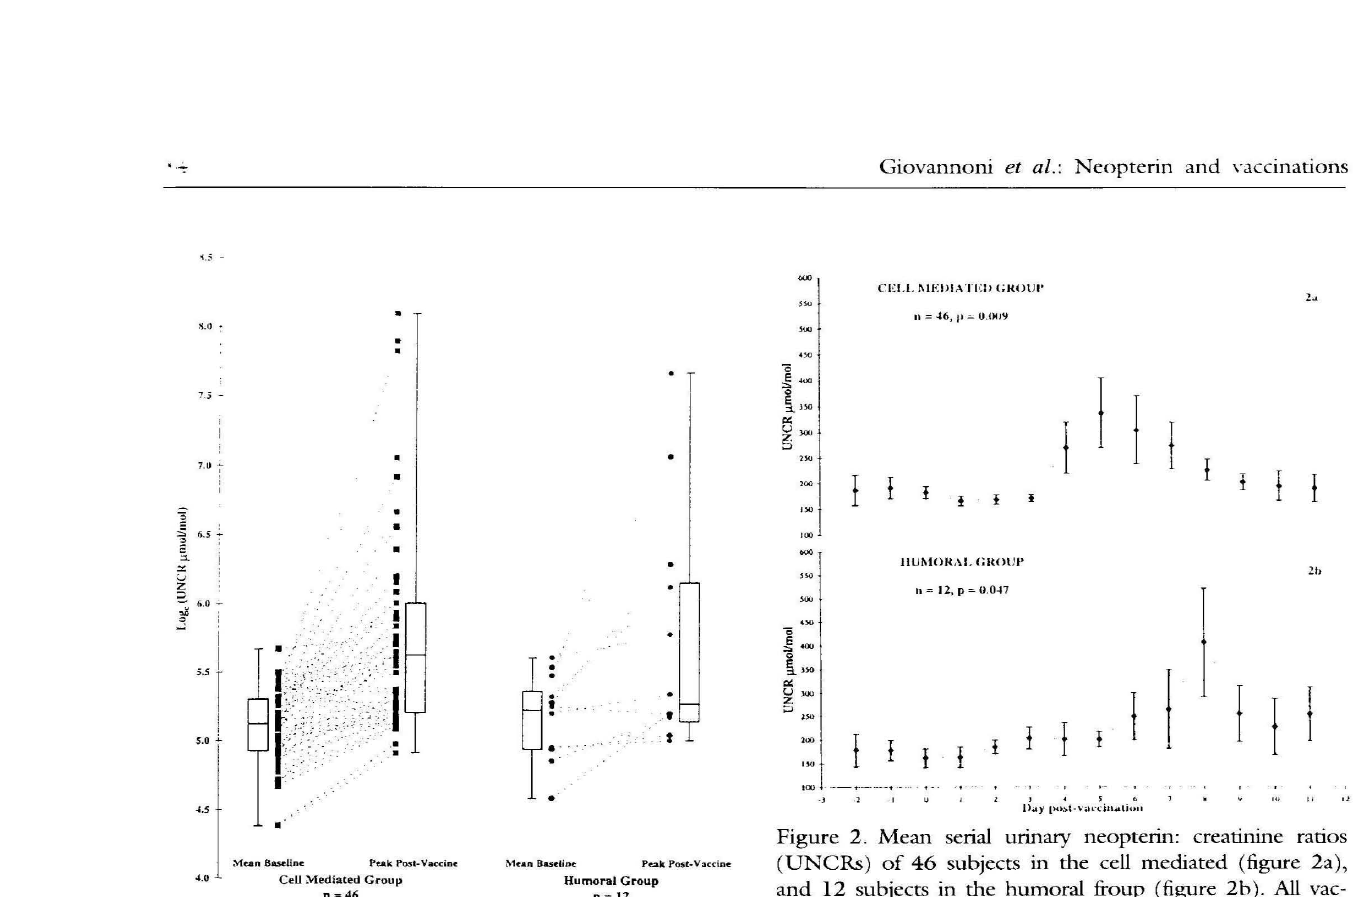
Figure 1. Scatter and box and whisker plot of mean base line urinary neopterin: creatinine ratio(UNCR)( day 2 pre to day 3 post-vaccination) and maximum peak UNCR (days 4 to 10 post-vaccination in 46 subjects receiving vac cinations known to stimulate cell mediated immunity (cell mediated group) and 12 subiects receiving vaccines known to stimulate humoral immunity (humoral group). The boxes represent the 25th to 75th percentiles divided by the median and the whiskers the maximum and minimum values.